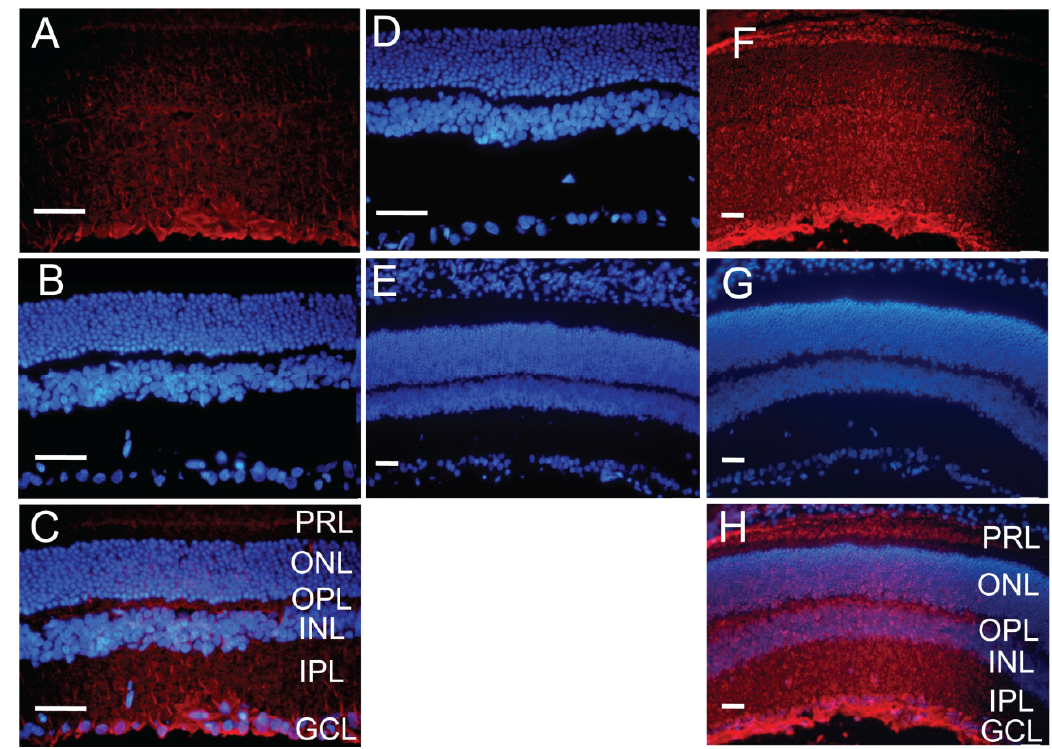
Figure 5. Expression of the vector encoding anti- CTGF shRNA in diabetic retinas after intravitreal injection. One week after injection, the retinas of diabetic rats were sectioned, and the expression of RFP from the injected vector was directly visualized ( A ) or detected by immunostaining ( F ) in all layers of retina. DAPI counterstaining ( B and G ) and merged pictures ( C and H ) are also shown. Retinal sections of the un-injected eyes ( D ) and the eyes injected with the vector without RFP ( E ) served as negative controls, and no RFP signal was visualized or detected in these sections. n = 5, PRL: photoreceptor layer, ONL: outer nuclear layer, OPL: outer plexiform layer, INL: inner nuclear layer, IPL: inner plexiform layer, GCL: ganglion cell layer. Scale bar = 50